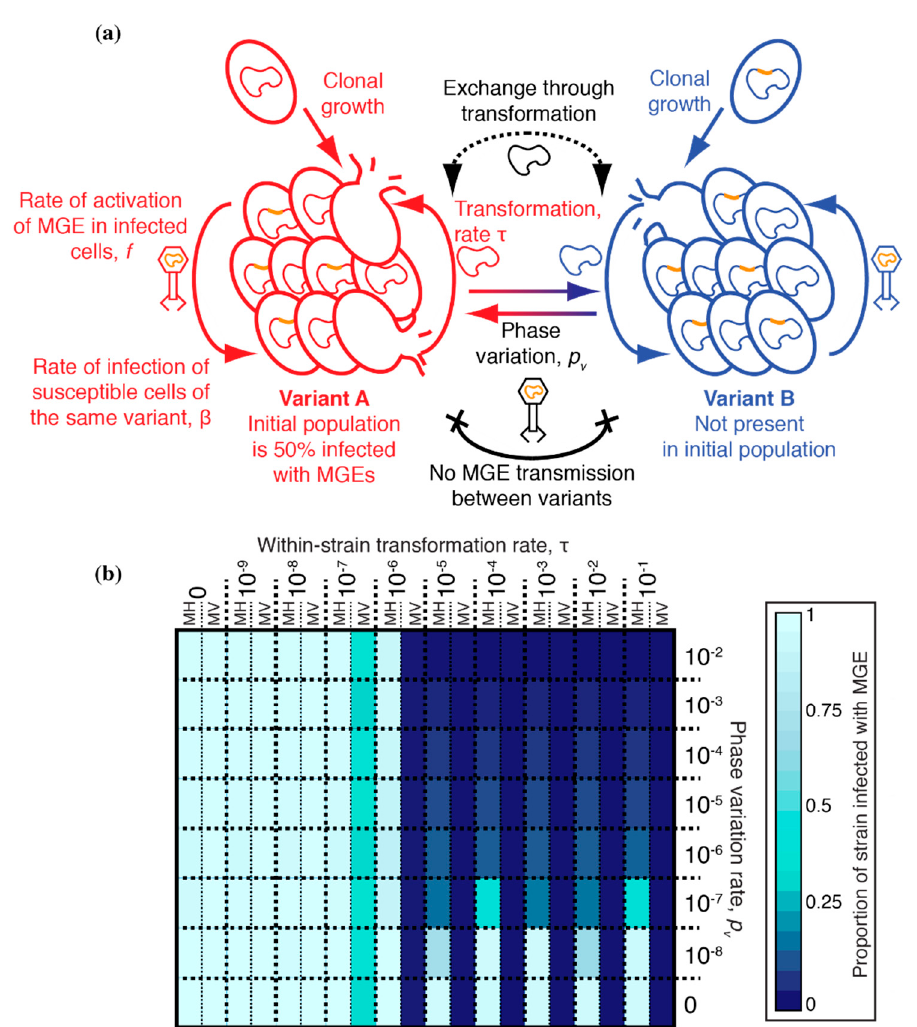
Figure 5. Simulations of sequence exchange between a transformable S. pneumoniae population expressing a phase-variable RMS. ( a ) Structure of the model. The cell population was initialized as being entirely of variant A, with 50% of cells carrying an MGE. The MGE present was either MV, which had a relatively greater tendency towards vertical transmission, or MH, which had a relatively greater tendency towards horizontal transmission. Phase variation at an RMS occurred at a rate p v , generating a mixed population of variants, between which MGEs could not transmit, owing to the restriction barrier. Transformation was asymmetric and not inhibited by the restriction barrier, as RMSs are only expected to inhibit acquisition of new genes by transformation. ( b ) Heatmap showing the results of simulations. Variation in within-strain transformation rate ( τ ) is shown across columns, and variation in p v shown across rows. Each cell is split in two, with the halves showing the proportion of cells infected with an MGE in simulations with MH (left) and MV (right). These values are calculated as the mean across three replicate simulations.